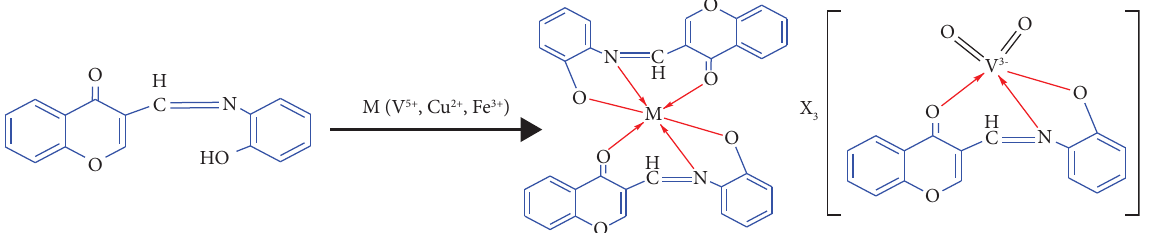
Figure 7: Proposed structures for the SL-Cu 2+ , SL-Fe 3+ , and SL-V 5+